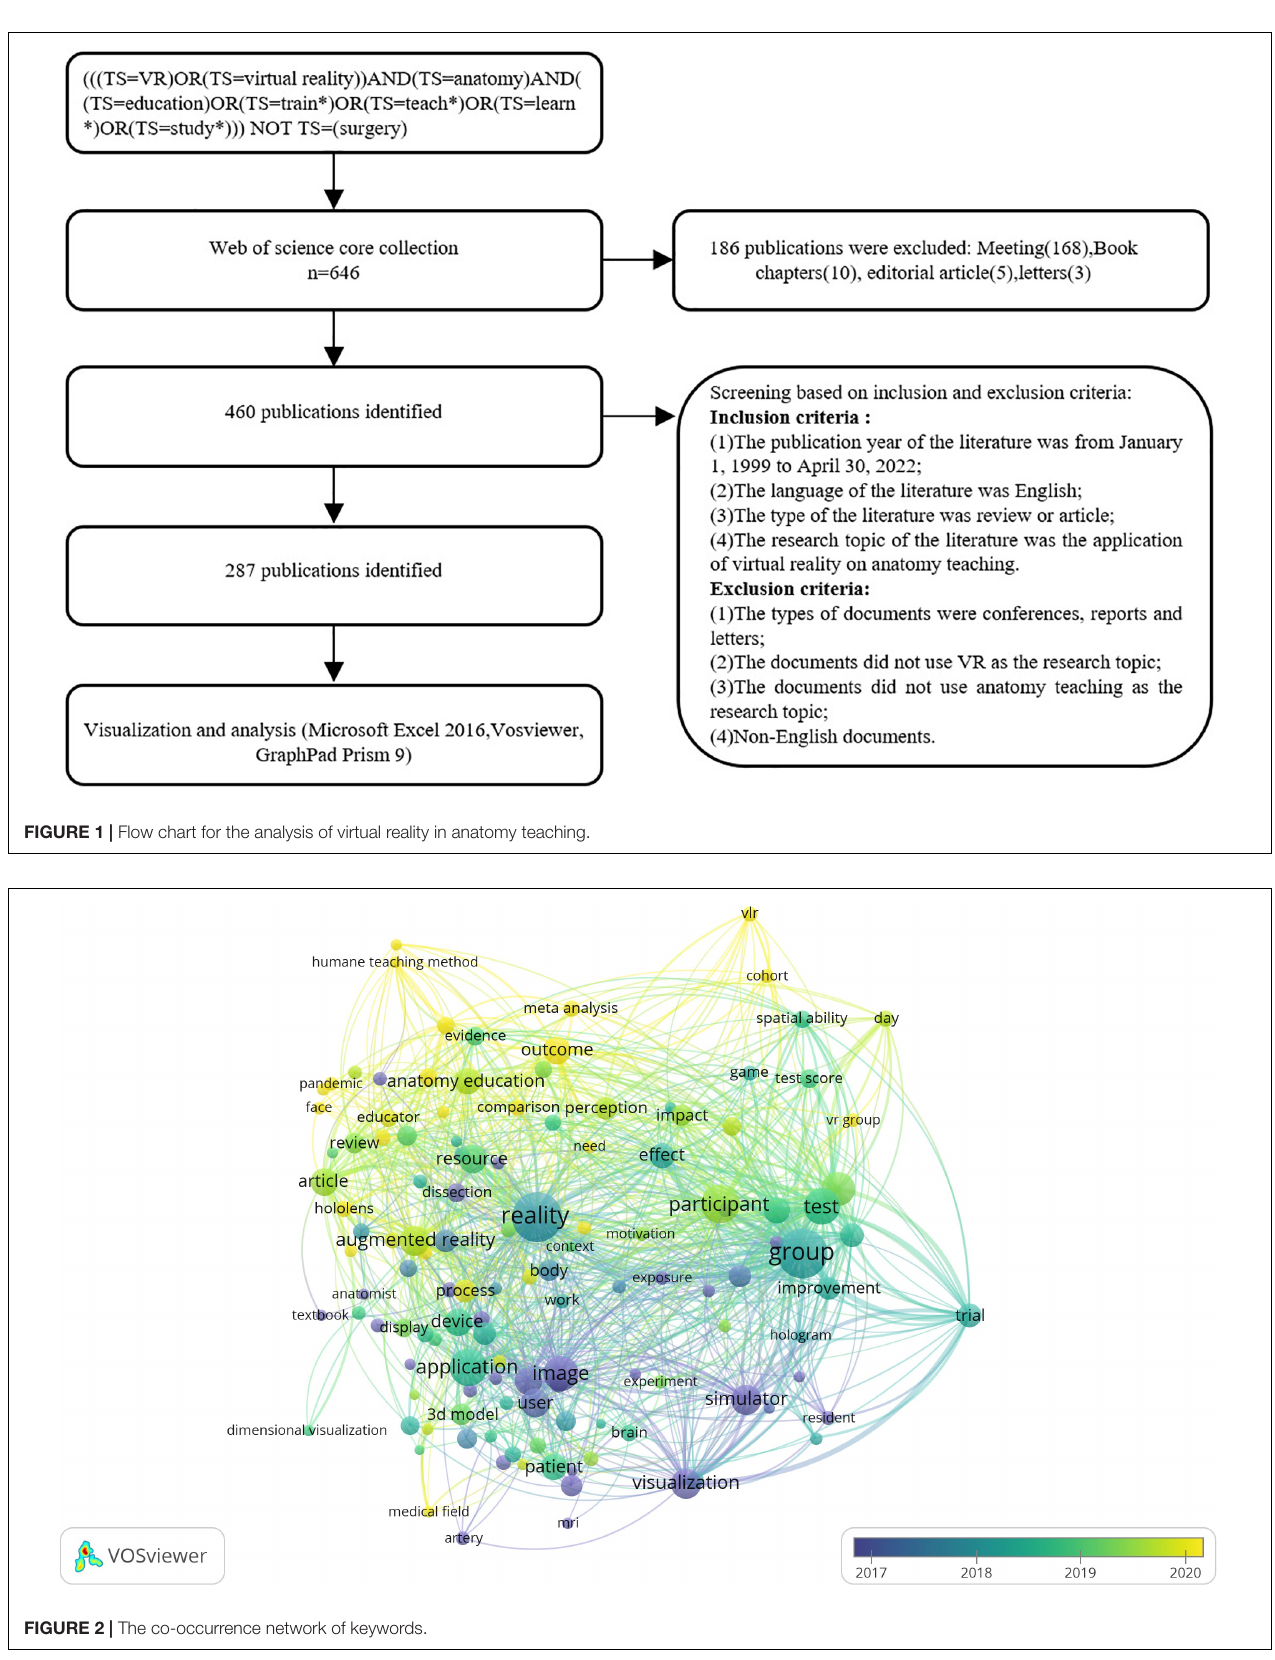
FIGURE 2 | The co-occurrence network of